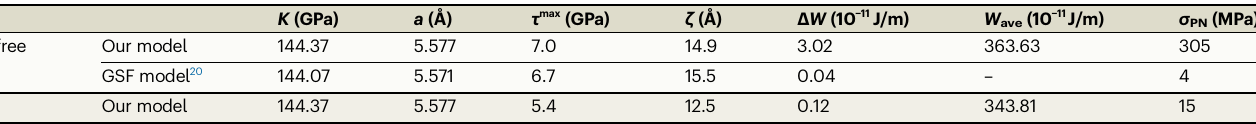
Table. 1 | The elastic coef fi cient ( K ), the periodicity of total mis fi t energy ( a ), the maximum of restoring force ( τ max ), the half- width of dislocation core ( ζ ), the Peierls energy barrier ( Δ W ), the average mis fi t energy ( W ave = 1 -- stress ( σ PN ) for the [011](0 11) edge dislocation in SrTiO 3 calculated based on the PN